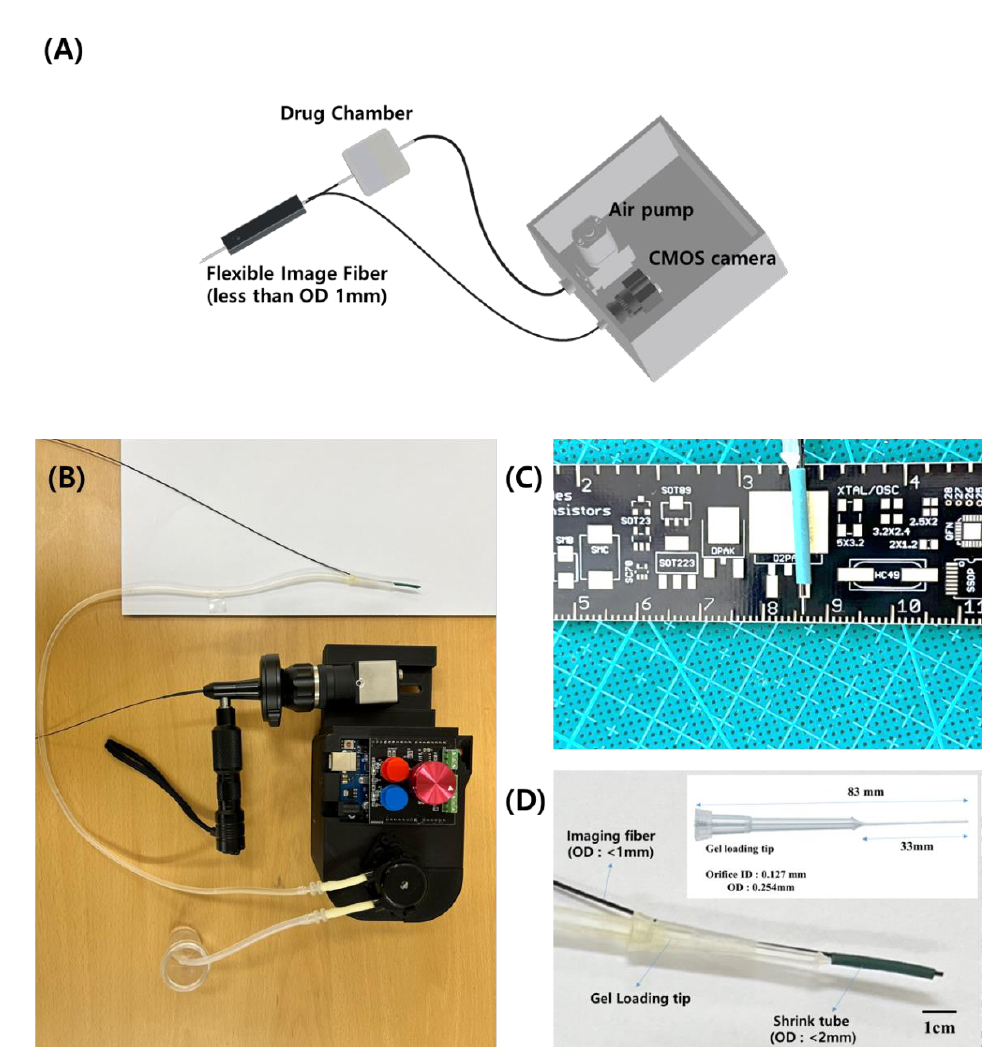
Figure 1. The proposed Flexible-Imaging-Fiber-guided intratracheal administration system. ( A ) schematic diagram of the flexible intratracheal imaging and administration system, ( B ) an image of the system, and ( C , D ) enlarged image of the video and drug administration probe. (OD: outer diameter, ID: inner diameter, <: less than).